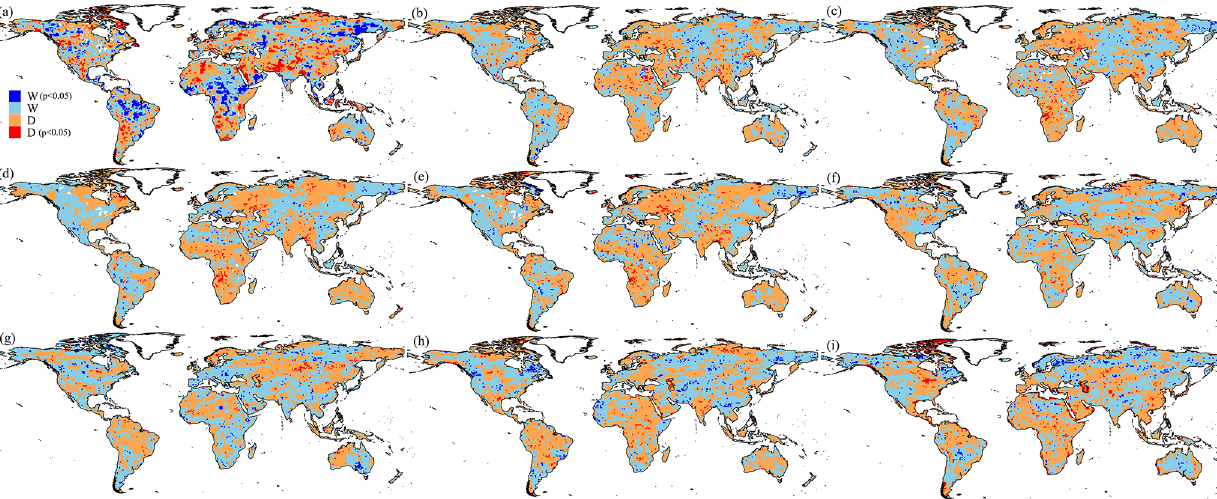
Figure 2. Global distribution of the classification in long-term trends in P − E − R during (a–f) the historical (1985–2014) and future (2071– 2100) periods under (g) SSP126, (h) SSP245, and (i) SSP585 scenarios. Note that the historical results are based on the (a) observation-based products (i.e., CRU P , GLEAM E , and G-RUN R ), (b) WGHM, (c) VIC, (d) CLSM, (e) Noah, and (f) ensemble mean of eight GCMs, respectively. The future results are based on the ensemble of eight GCMs. “D” and “W” indicate regions with drying and wetting trends,